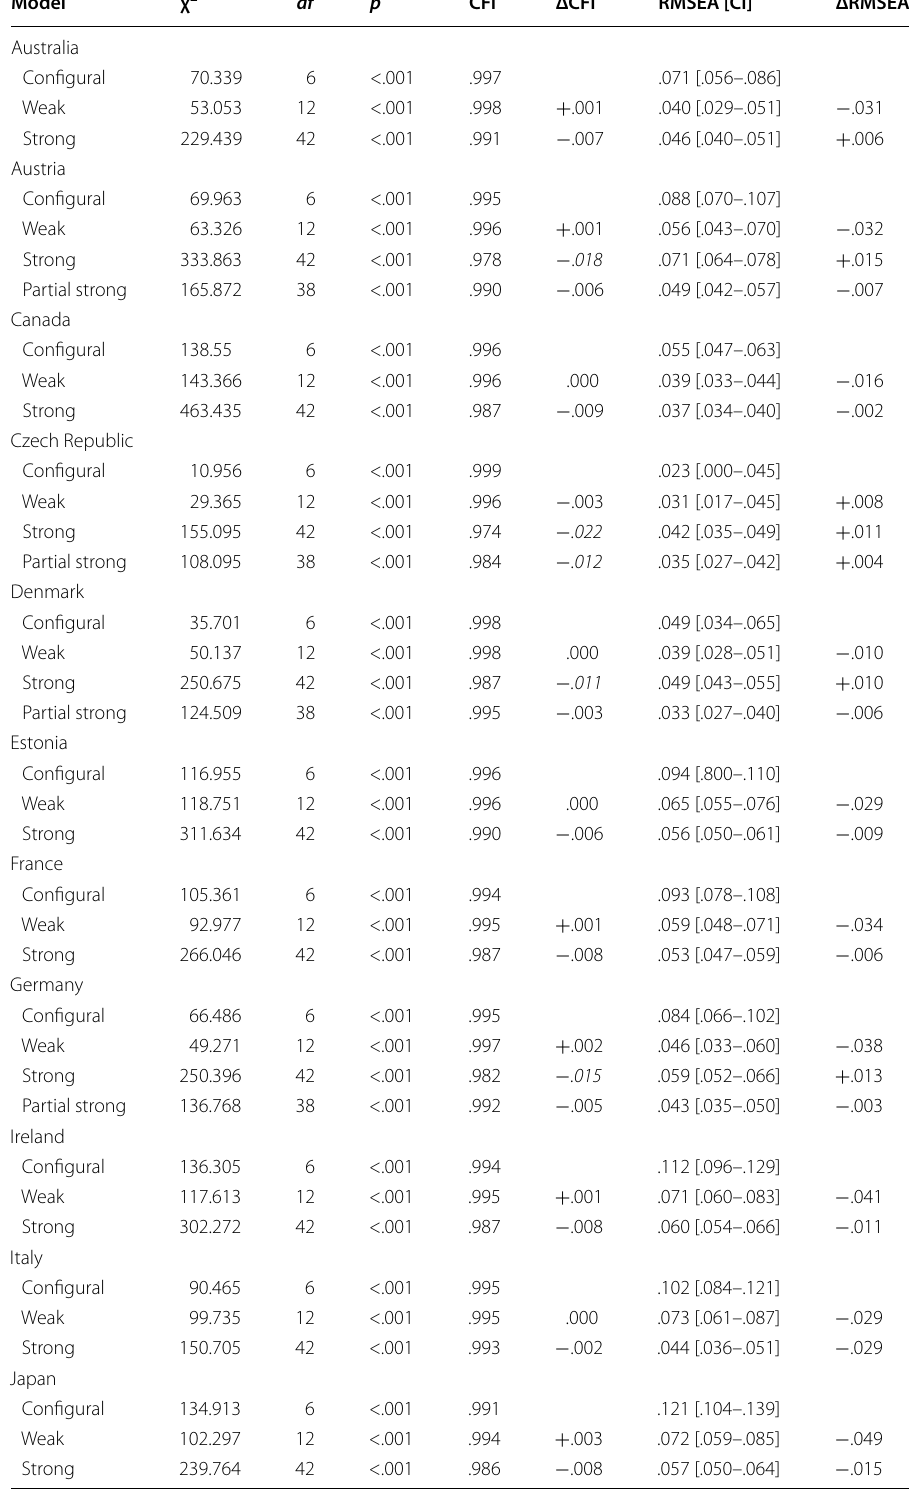
Table 4 Detailed model fit with age groups as grouping variable